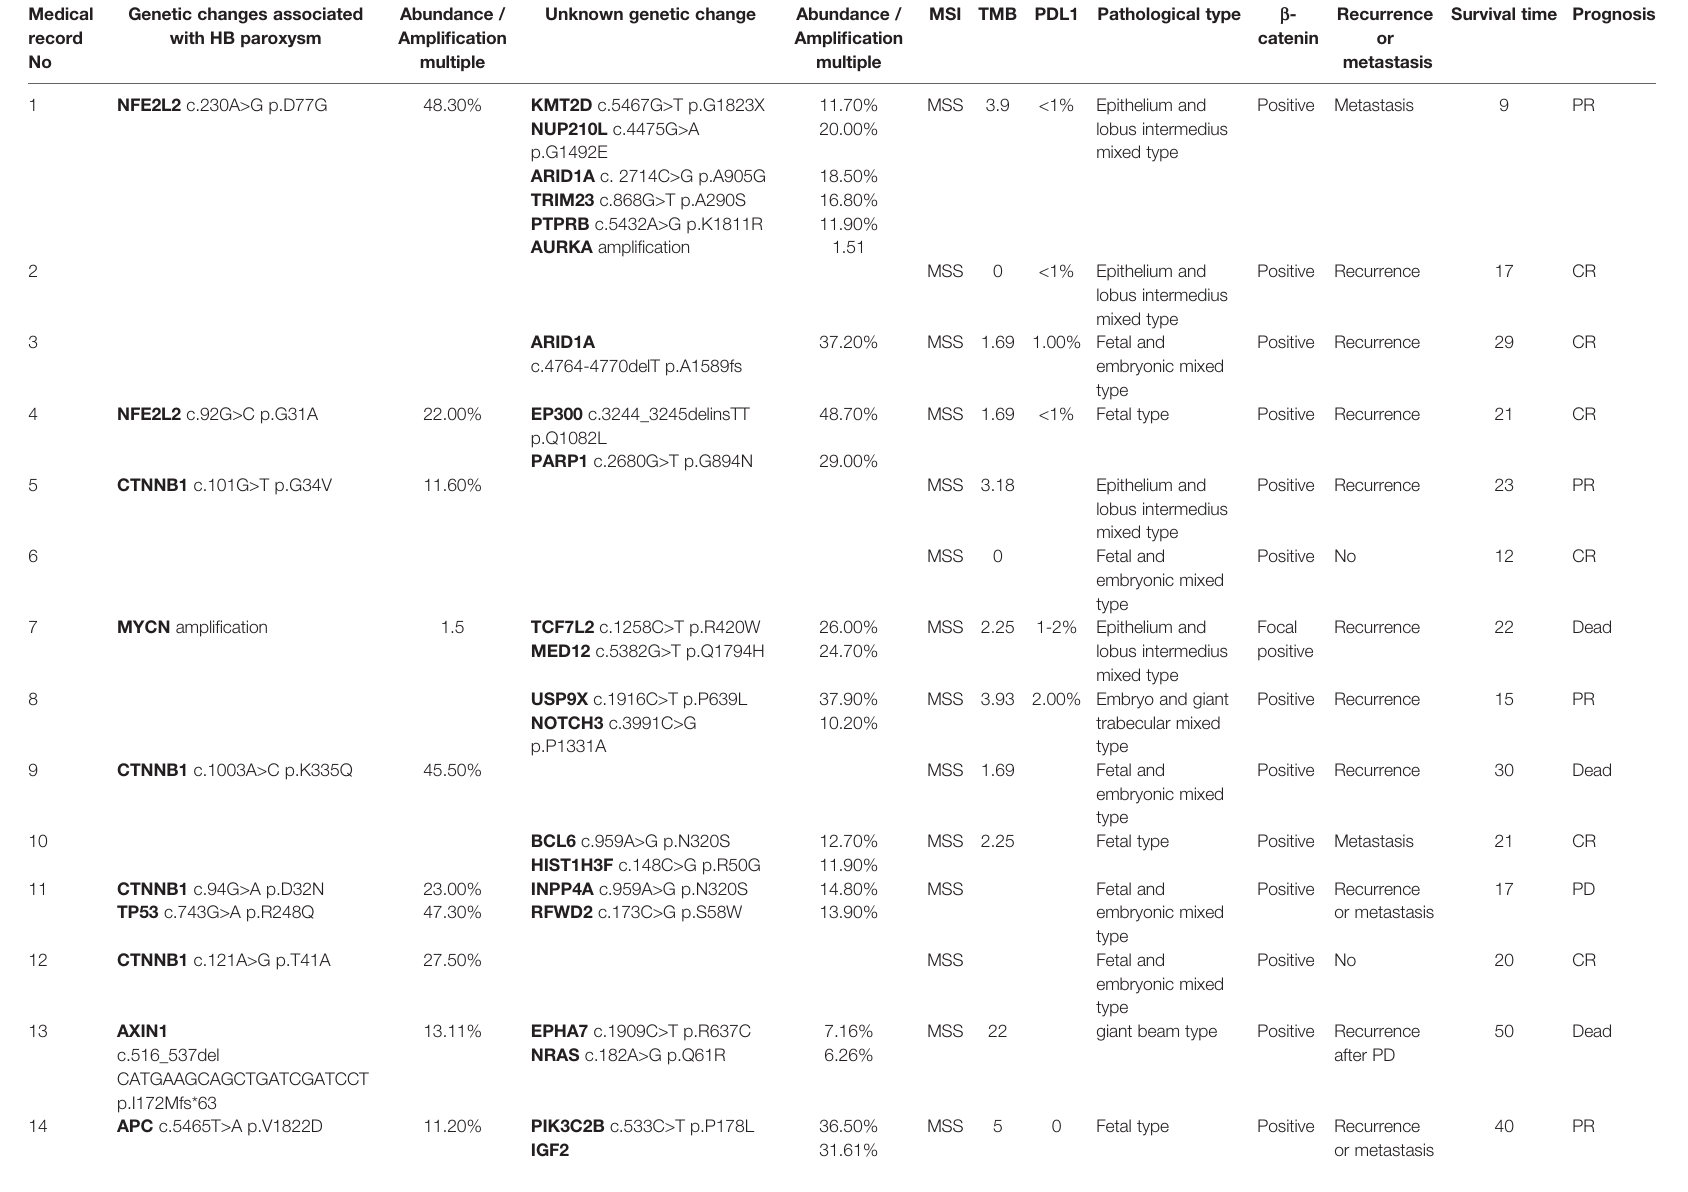
TABLE 2 | Speci fi c genotypes of 19 clinical pediatric patients with HB. HB,